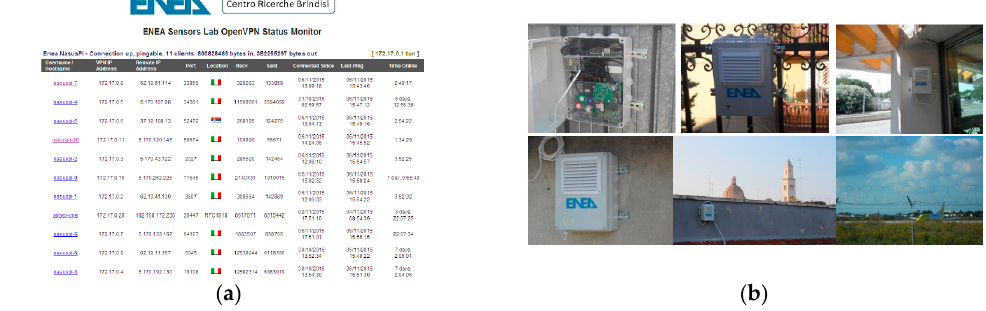
Figure 2. ( a ) Virtual Private Network (VPN) by ENEA (Brindisi Research Center) to manage the deployed air quality sensor network; ( b ) Selected locations in Bari (Italy) of the installed stationary nodes AIRBOX for urban air quality monitoring operated by